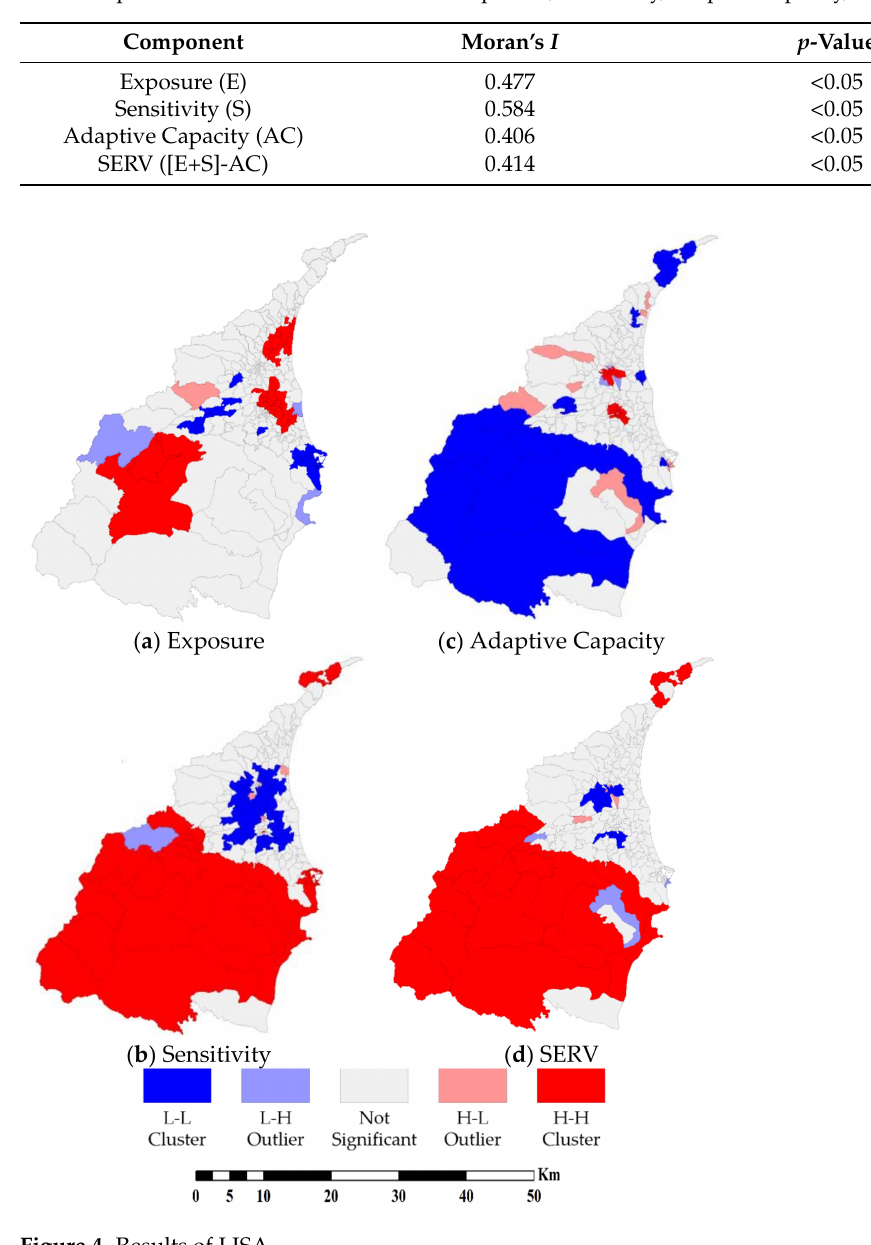
Figure 4. Results of